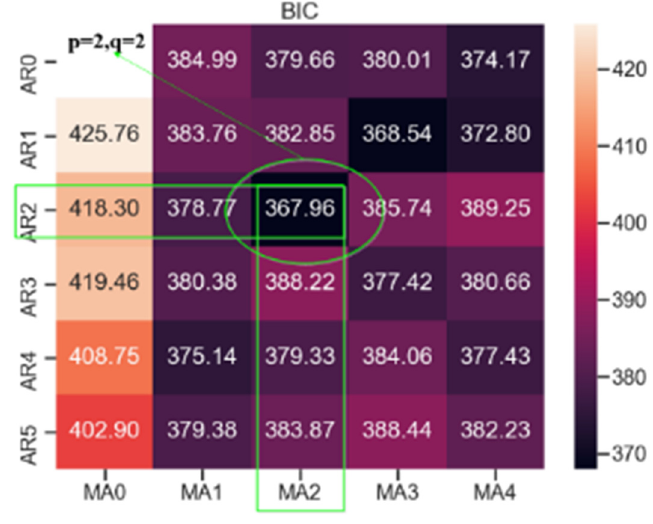
Figure 9. The BIC heat map of different model parameters.